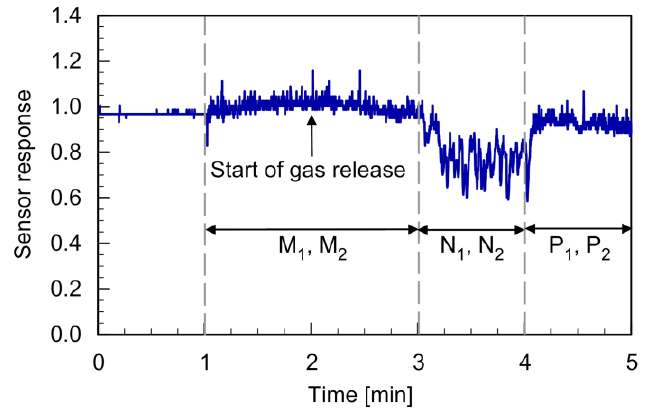
Figure 11. Setup of the flight experiment under no cross-flow conditions (top view). Quadcopter 1 was moved from point M 1 through point N 1 to point P 1 , while quadcopter 2 was moved from point M 2 through point N 2 to point P 2 . Figure 12. Response curve of the MiCS-5521 sensor during the flight under no cross-flow conditions. Reprinted from [24].